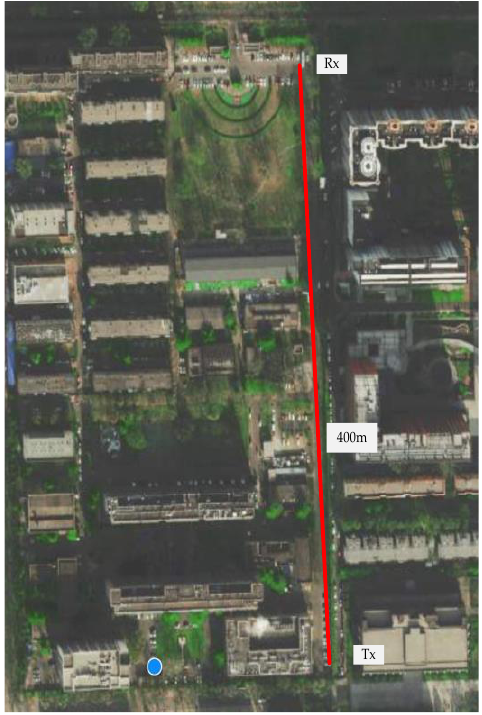
Figure 4. The location of the receiver and transmitter.